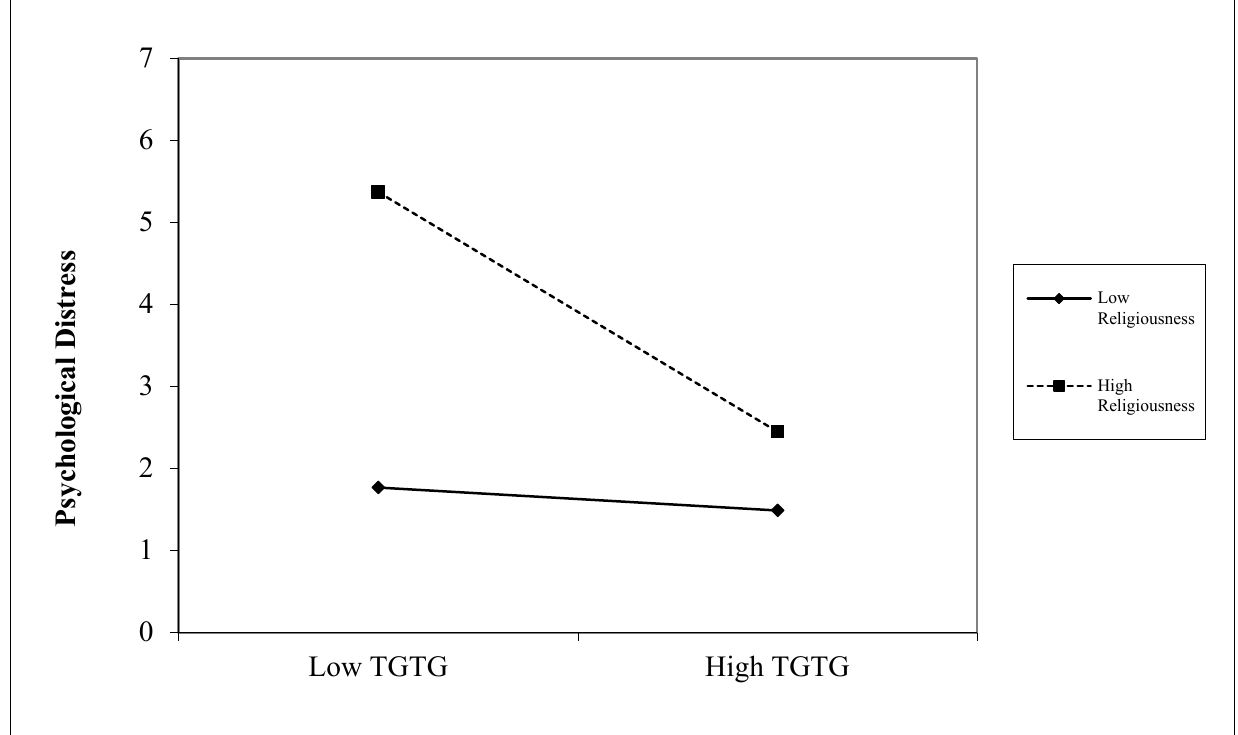
Figure 1. Interaction between General Religiousness and Gratitude to God Predicting Levels of Psychological Distress.